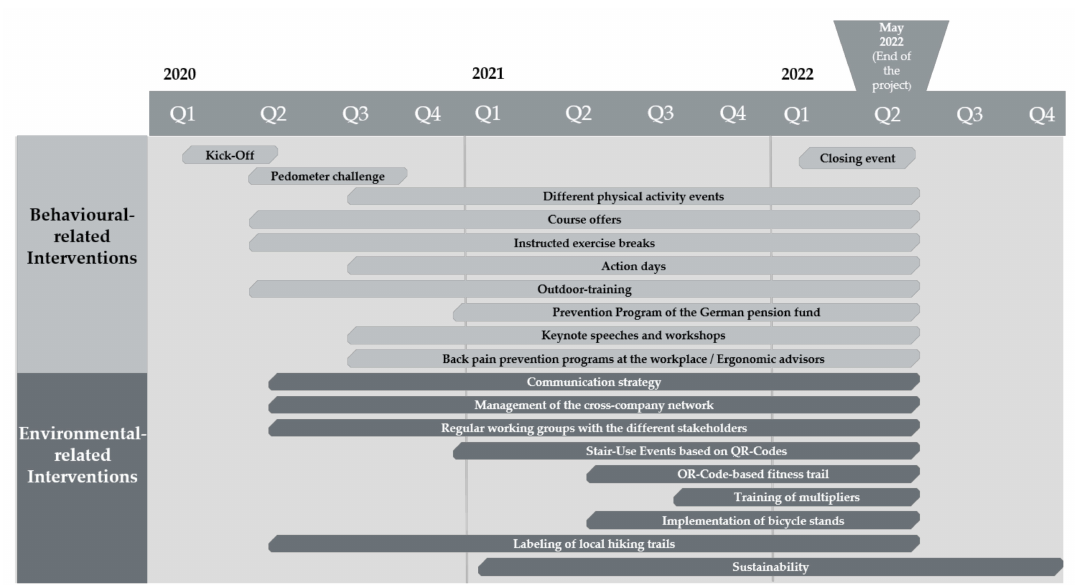
Figure 3. Overview and timeline of the multicomponent intervention. Q: